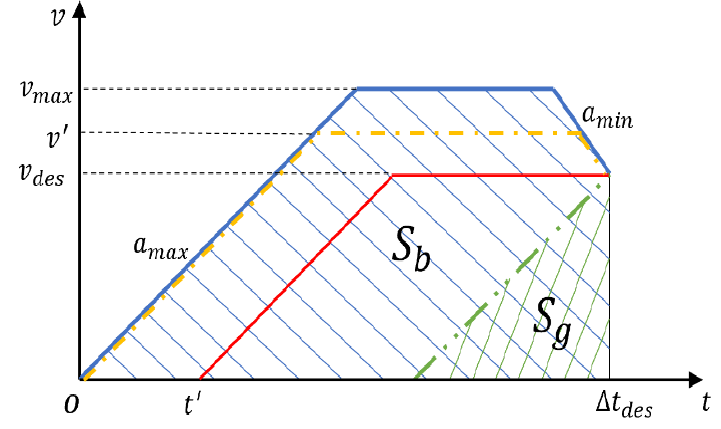
Figure 4. Feasible speed trajectories for vehicles in the self-adjusting stage.